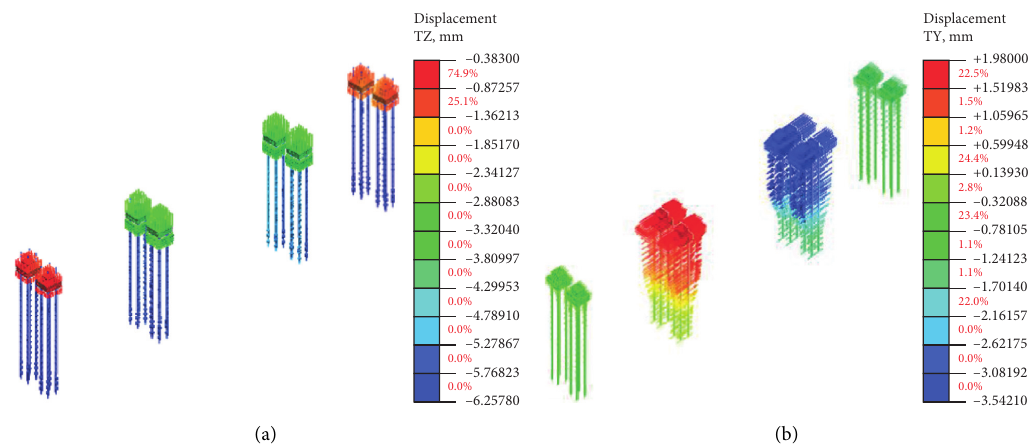
Figure 16: Morphing clouds of pile foundation. (a) Settlement diagram. (b) Horizontal displacement